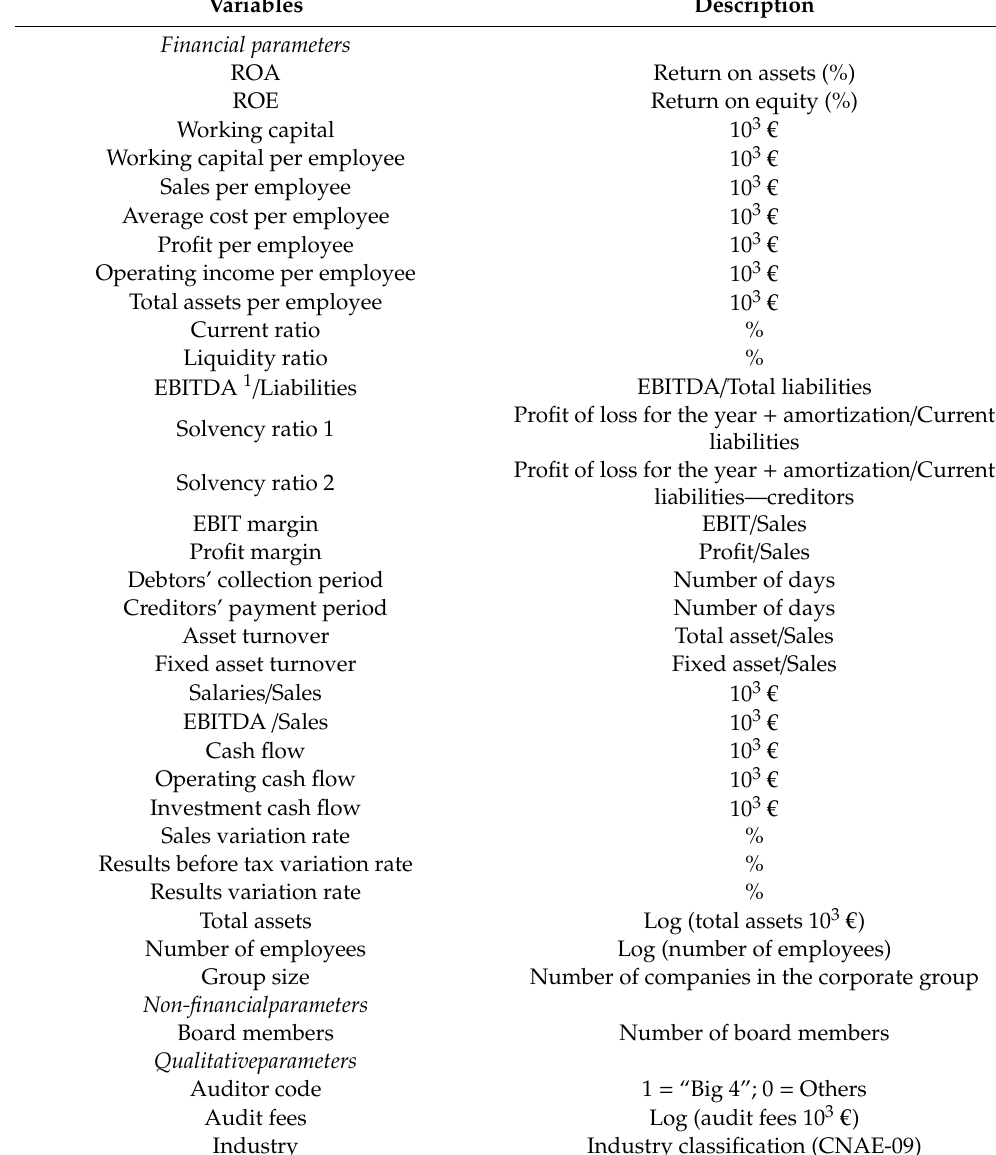
Table 2. Independent